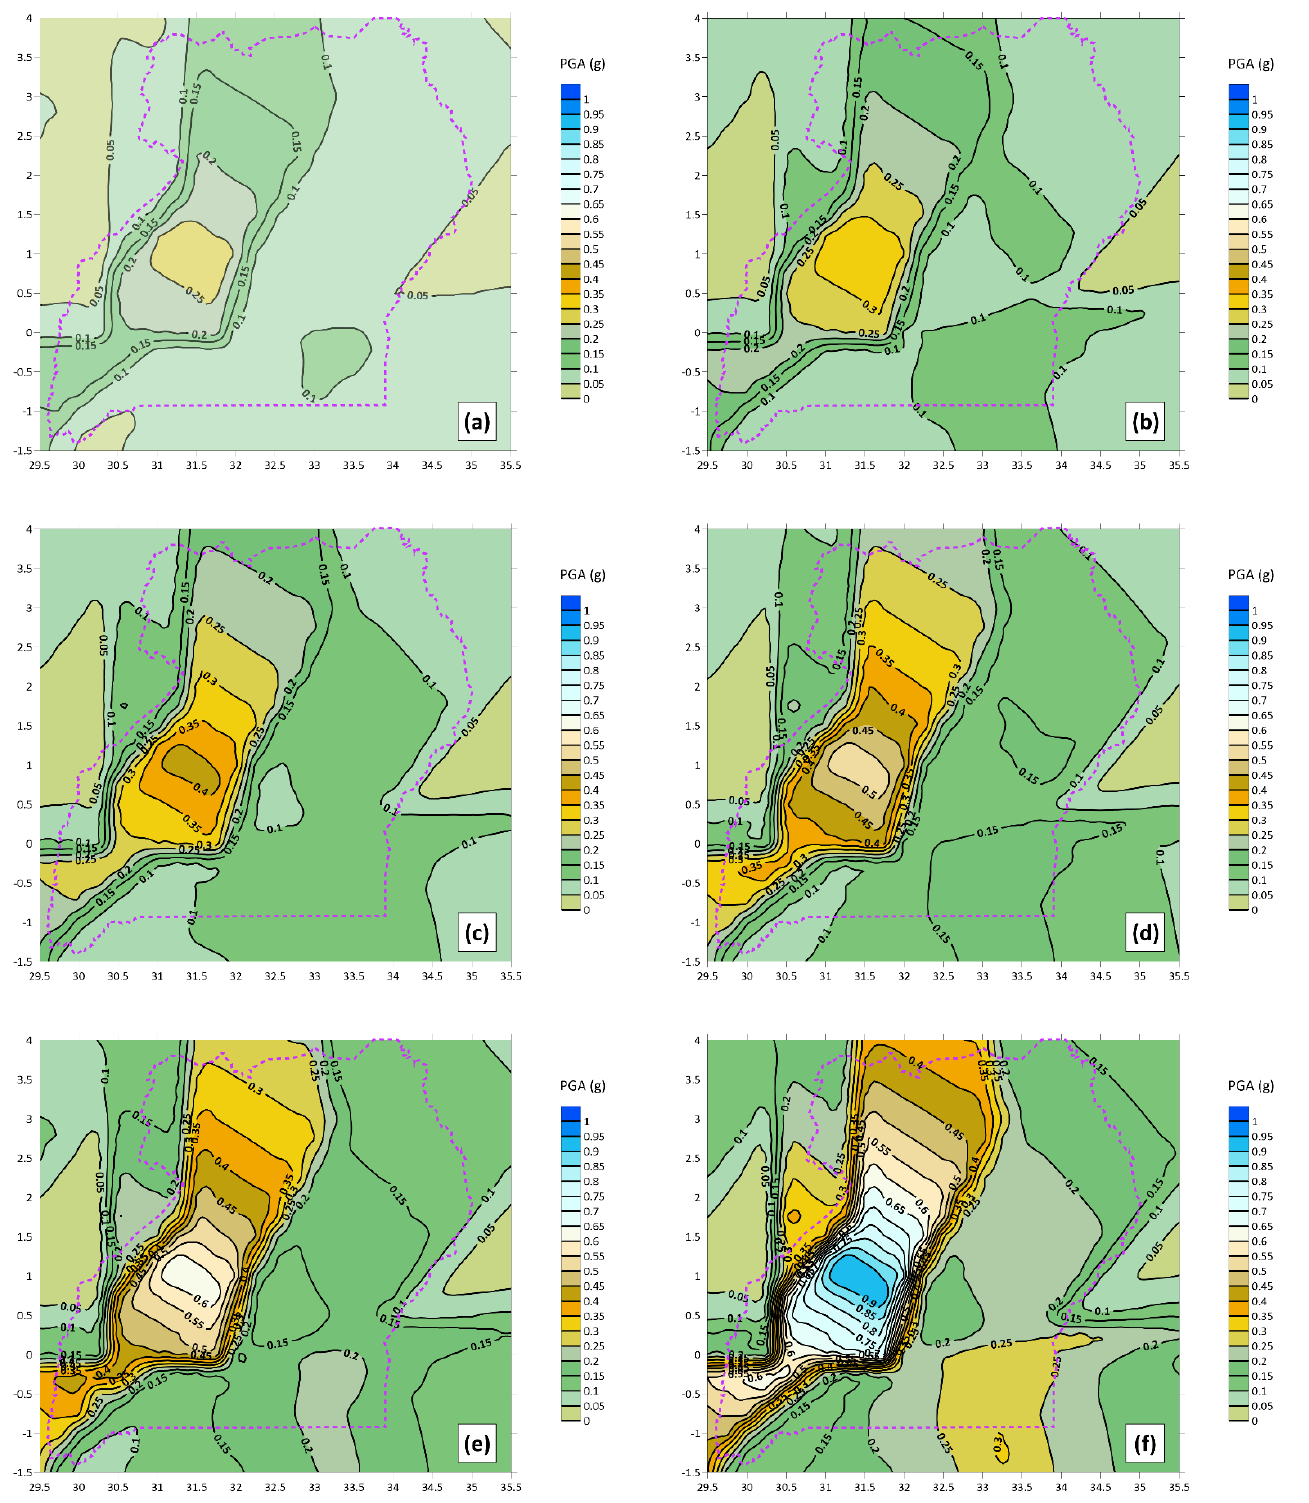
Figure 7. Progression and distribution of mean PGA values in Uganda computed for 10% probability of exceedance in ( a ) 5 years, ( b ) 10 years, ( c ) 20 years, ( d ) 50 years, ( e ) 100 years, and ( f ) 500